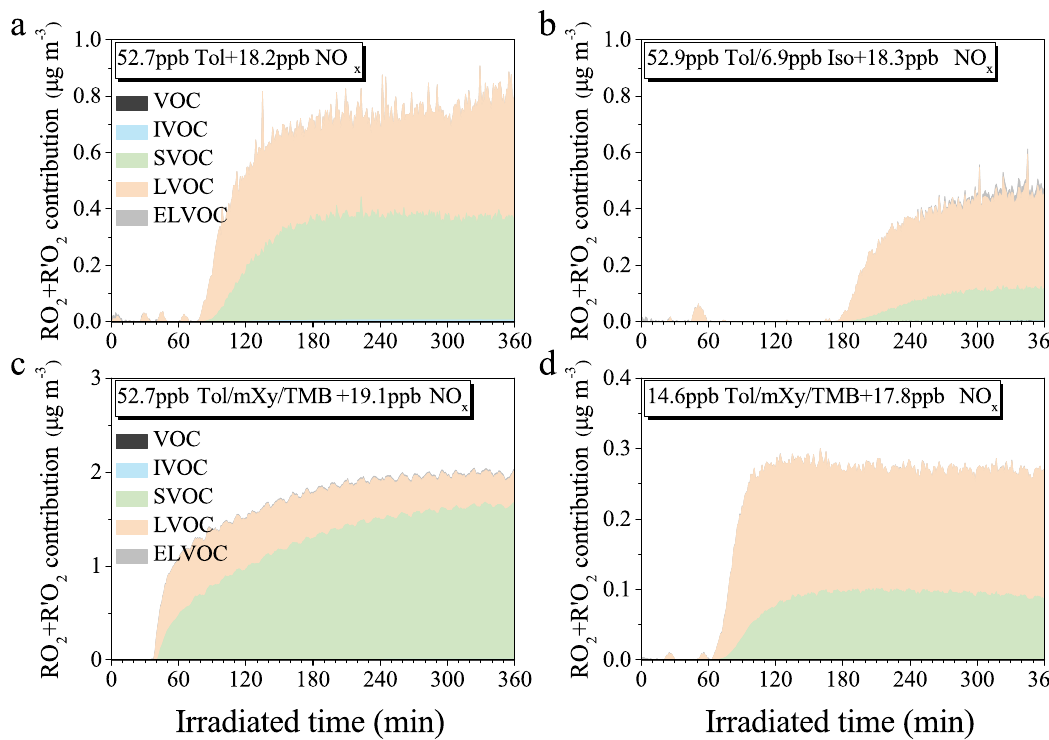
Fig. 4 Time series of the contribution of organic peroxides. Contribution of organic peroxides derived from RO 2 + R ʹ O 2 under different mixed VOC scenarios (i.e., toluene, mixed toluene and isoprene, as well as mixed toluene, m-xylene, and 1,3,5-trimethylbenzene) in the presence of NO x (~20 ppb) at a – c higher and d lower VOC concentration levels. The detailed experimental conditions can be found in Table